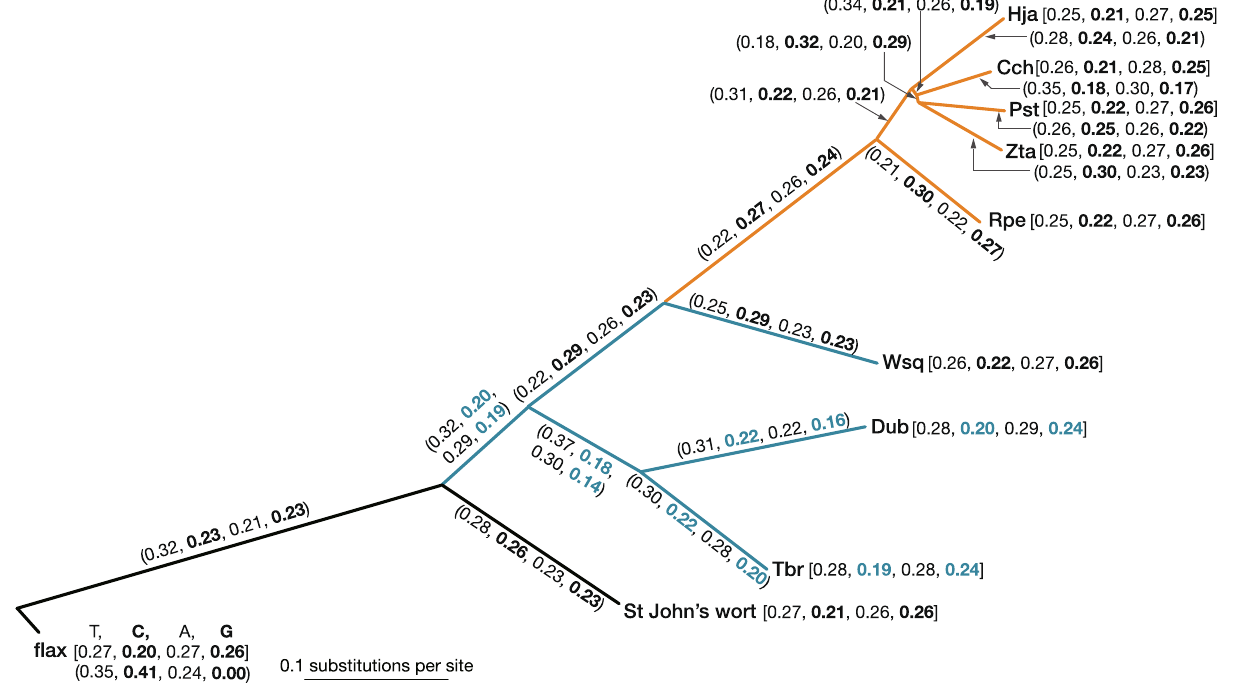
Fig. 4 A maximum-likelihood tree and estimates of base-frequency parameters for branches using a concatenated alignment of 1640 orthogroups. Numbers in parentheses are estimates of the frequency parameters in the HKY + dG + N2 model for the branch, while those in brackets are the base frequencies at the nodes. The frequency parameters and the base frequencies are shown in the order T, C, A, G in parentheses and brackets. Cch Cladopus chinensis , Dub Dalzellia ubonensis , Hja Hydrobryum japonicum , Pst Polypleurum stylosum , Rpe Rhyncholacis cf. penicillata , Tbr Terniopsis brevis , Wsq Weddellina squamulosa , Zta Zeylanidium tailichenoides . Bar indicates 0.1 substitutions per